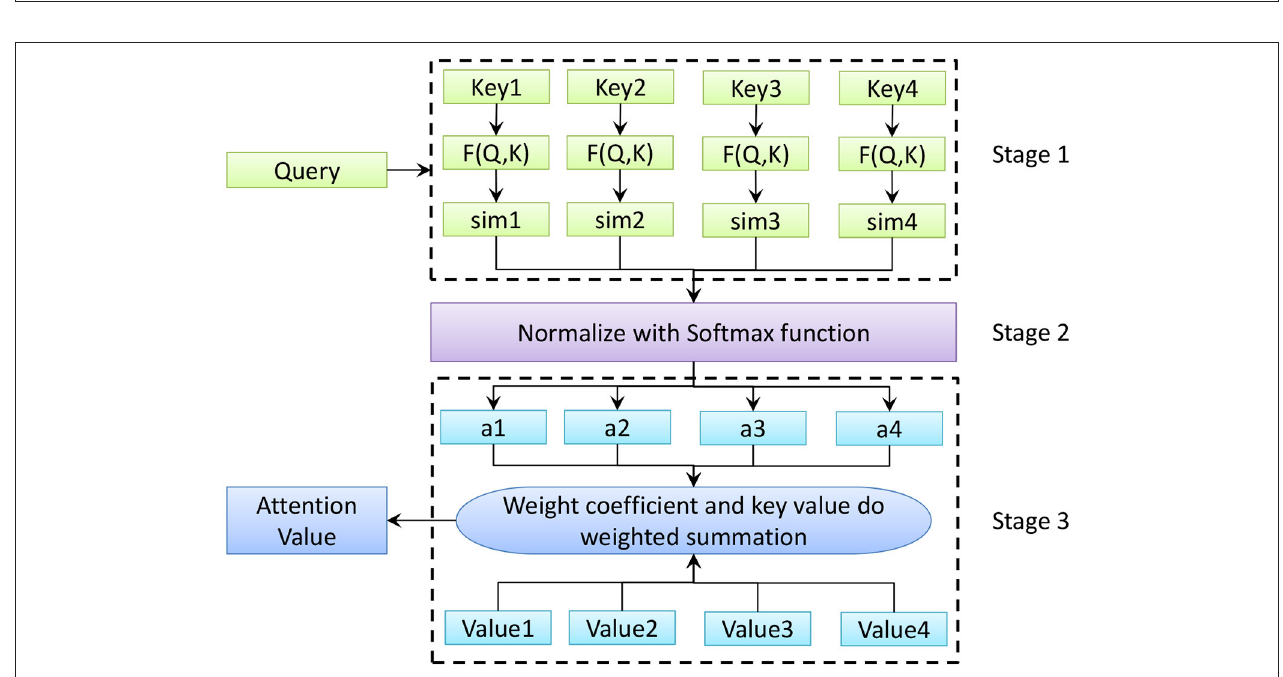
FIGURE 6 | Self-attention mechanism calculation process.